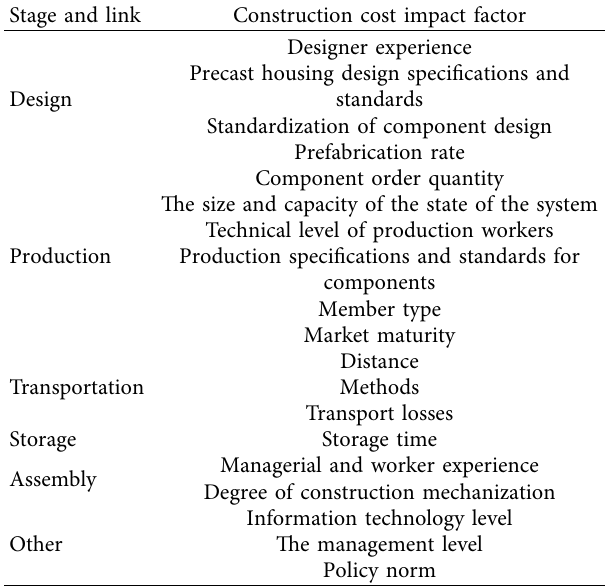
Table 1: Factors influencing the construction cost of prefabricated